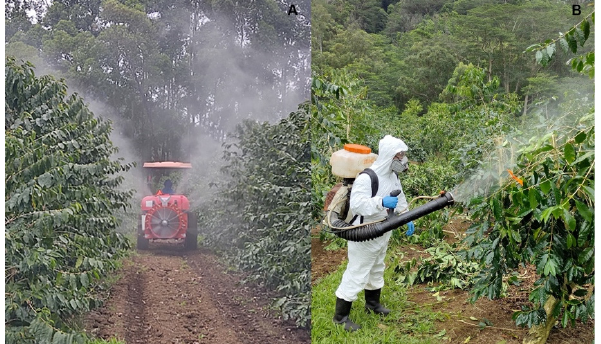
Figure 6. Spray application of fungicide using an air blast sprayer mounted on a tractor ( A ) and a backpack sprayer ( B ). Spraying with a tractor provides effective coverage of the foliage but requires wider row spacing and flat terrain. Backpack sprayers are more difficult to use effectively and can be more costly in terms of labor and time but are necessary on many farms in Kona where the terrain is steep and rocky, and trees are planted close together. Photos by Luis F. Aristizábal.